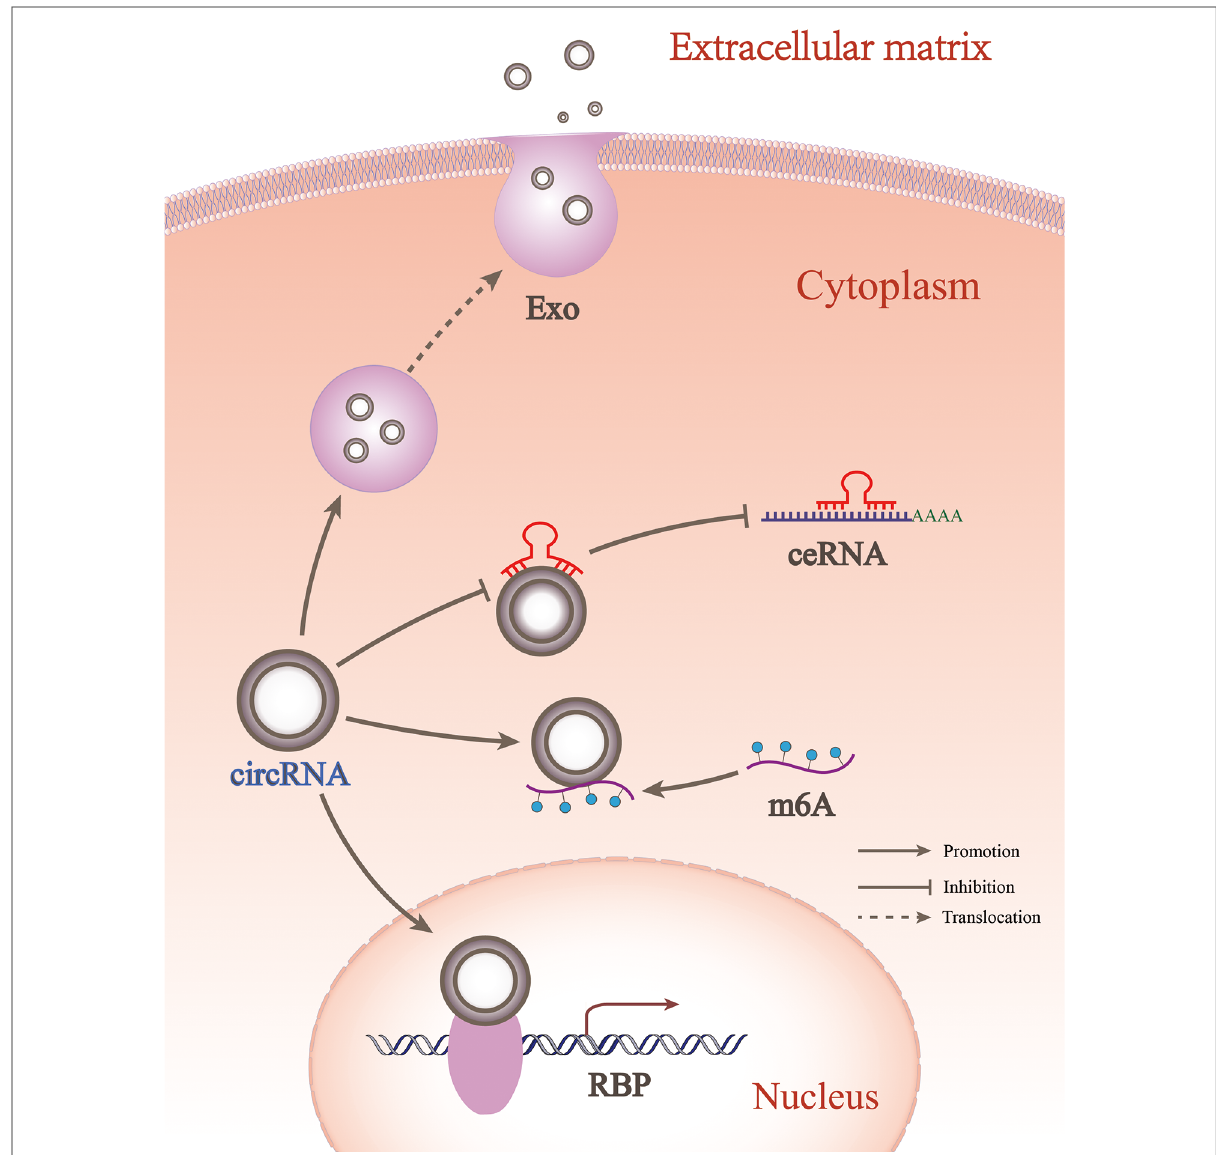
FIGURE 4 CircRNA participates in OA in different forms. circRNA could regulate OA between cells through exosomes, while within cells it could regulate OA through ceRNA, RBP, and m6A